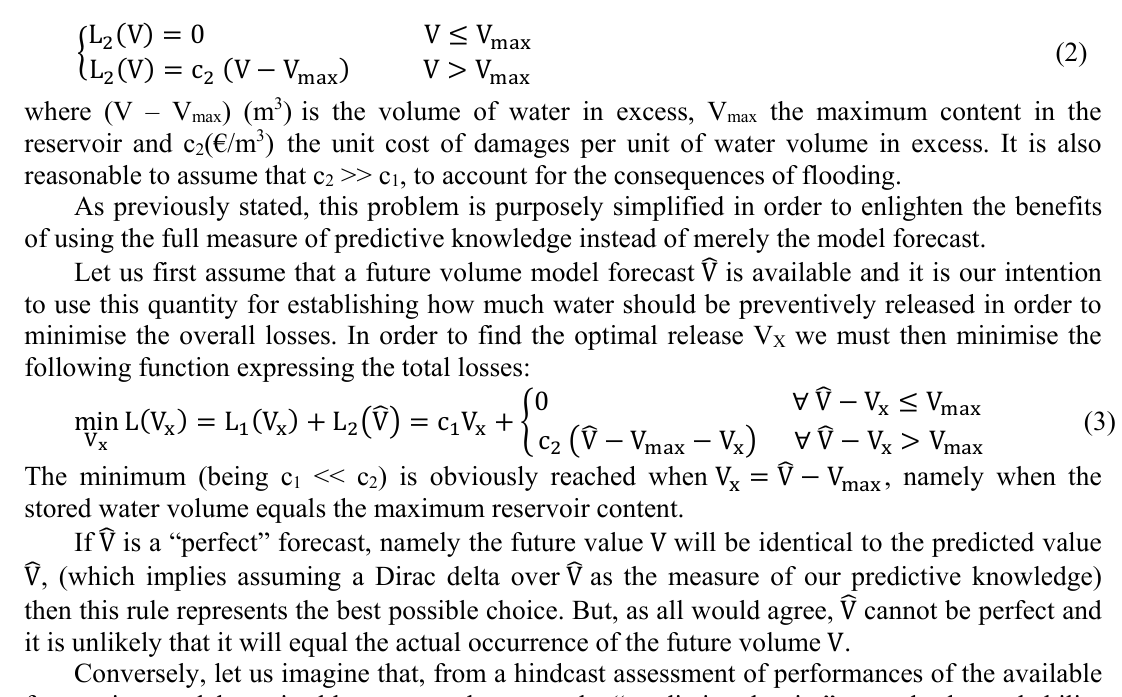
Fig. 2 The simple schematic representation of the reservoir management